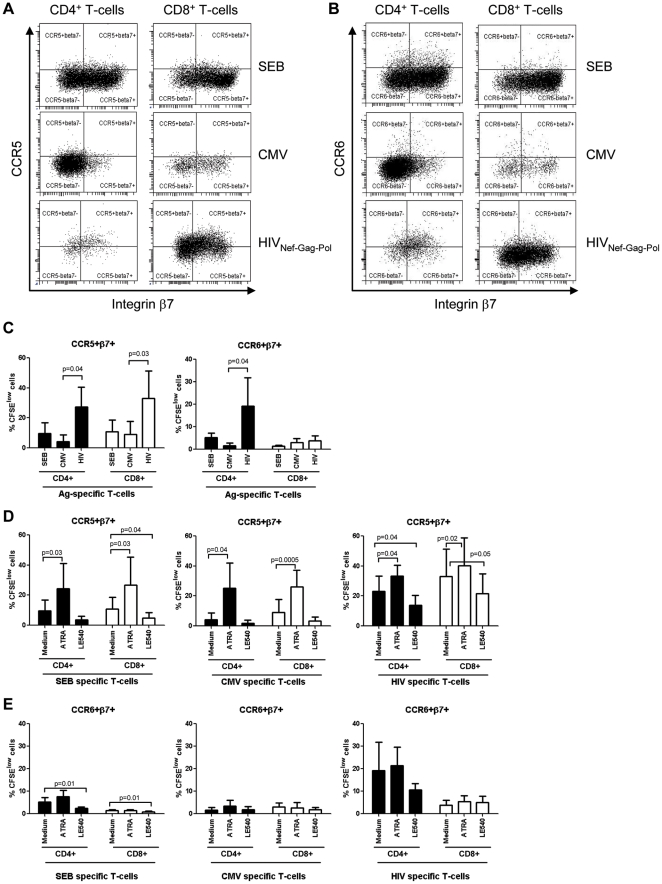
Retinoic acid upregulates the frequency of HIV-specific T-cells with a β7+CCR5+ but not β7+CCR6+ phenotype.PBMC from SP subjects were loaded in CFSE (0.5 µM) and stimulated as in Figure 5. Cells were stained with a cocktail of fluorochrome-conjugated CD3, CD4, and integrin β7, and CCR5 or CCR6 Abs. CFSElow CD4+ and CD8+ T-cells specific for SEB, CMV, and HIVNef-Gag-Pol peptide pool were analyzed for the co-expression of (A) integrin β7 and CCR5 and (B) integrin β7 and CCR6. The effects of RA and LE540 on the frequency of Ag-specific CD4+ and CD8+ T-cells exhibiting a β7+CCR5+ or β7+CCR6+ phenotype were then analyzed. (A–B) Shown are results from one representative SP subject and (C–E) statistical analysis of results from experiments performed with cells from five SP subjects (mean±SD). Paired t-Test p-values are indicated in the figures.